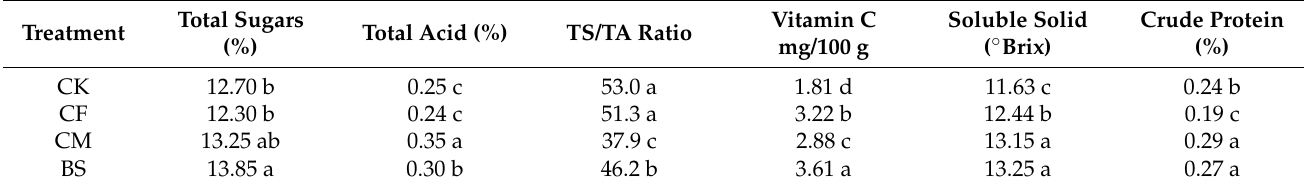
Table 3. Effects of different fertilizers on chemical properties of apple fruit.